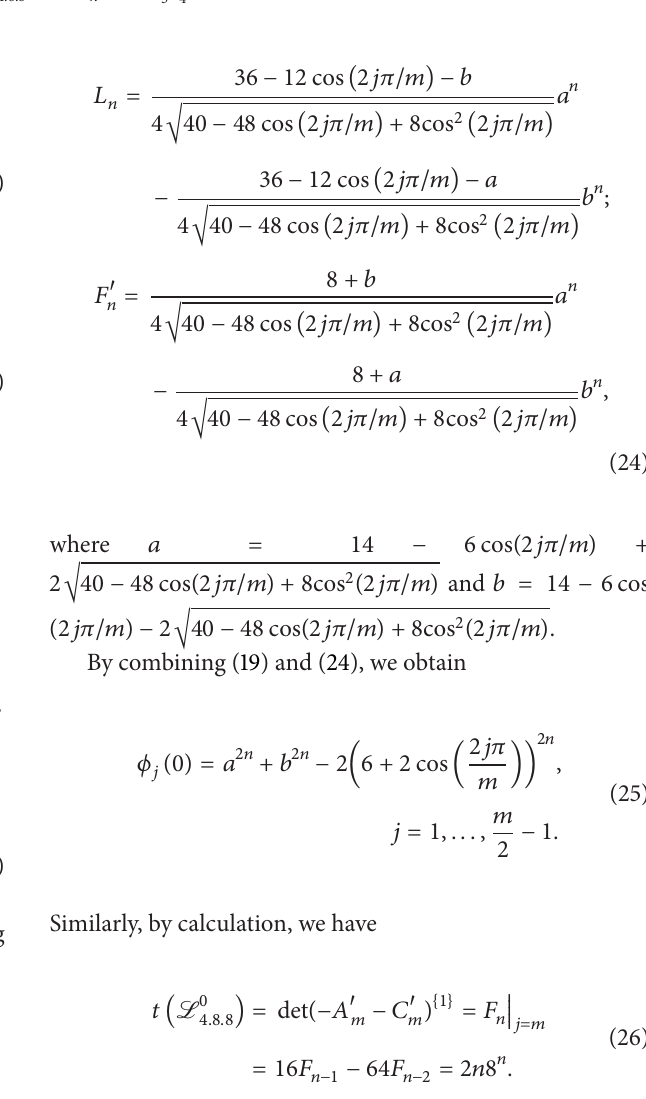
Figure 2: (a) L 0 4.8.8 ; (b) L 0 ℎ ; (c) L 0 3 3 ⋅4 2